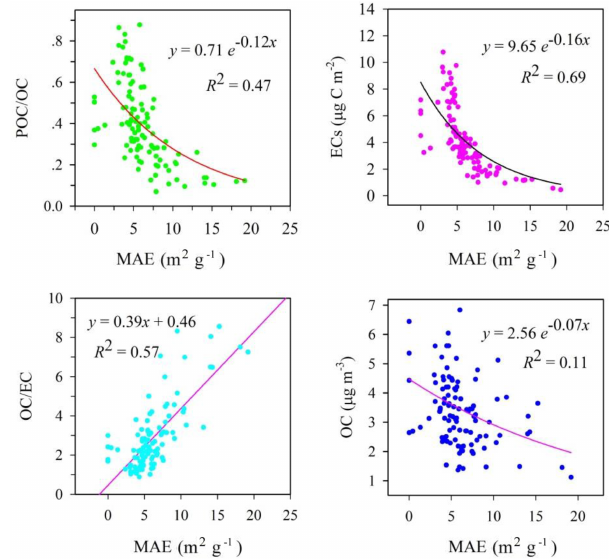
Figure 10. Regression analysis for scatter plot between EC MAE and POC / OC and OC / EC ratios, and between MAE and EC s and OC concentrations for aerosols sampled at